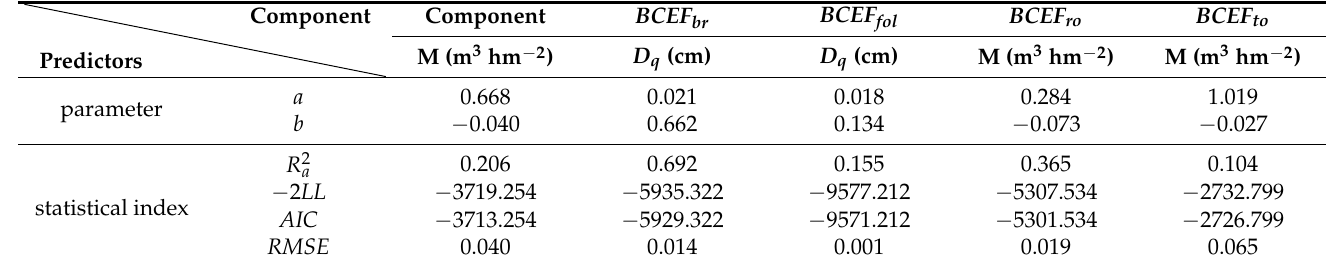
Table 4. Fitting Statistics of the Basic Model.